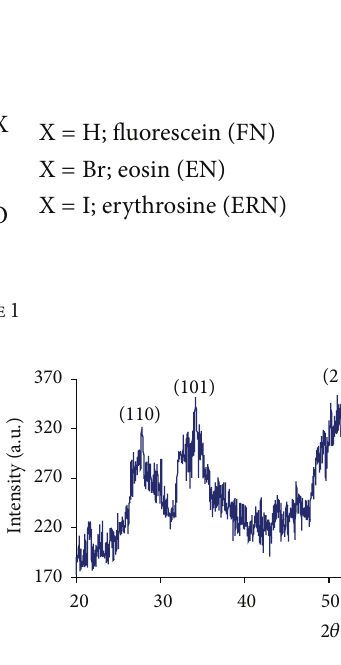
Figure 1: X-ray diffraction (XRD) spectrum of SnO 2